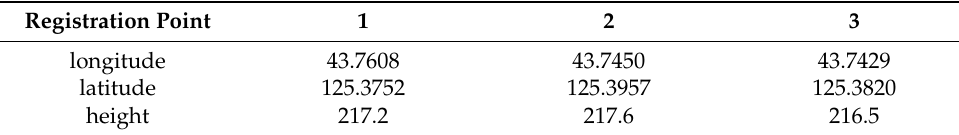
Table 3. Parameters of registration points.